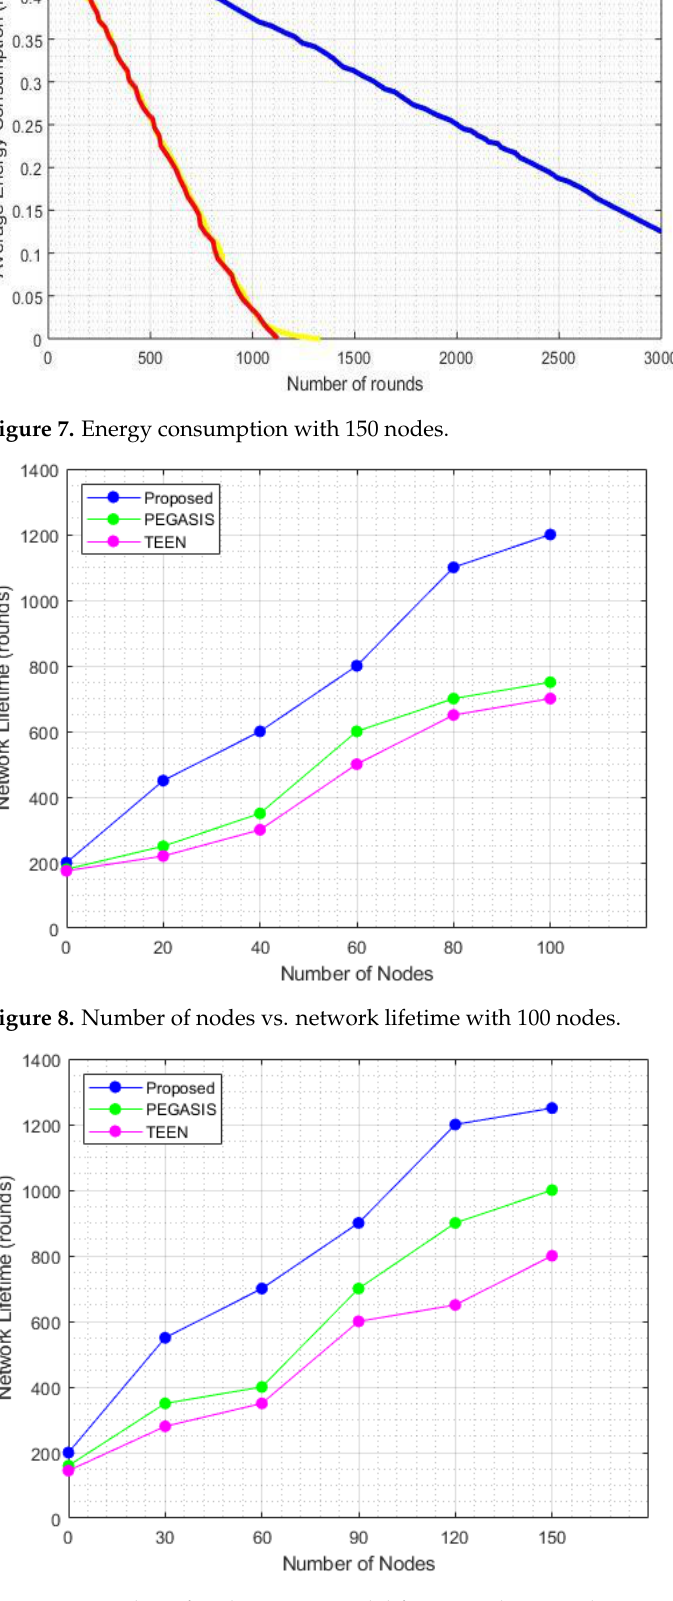
Figure 9. Number of nodes vs. network lifetime with 150 nodes.